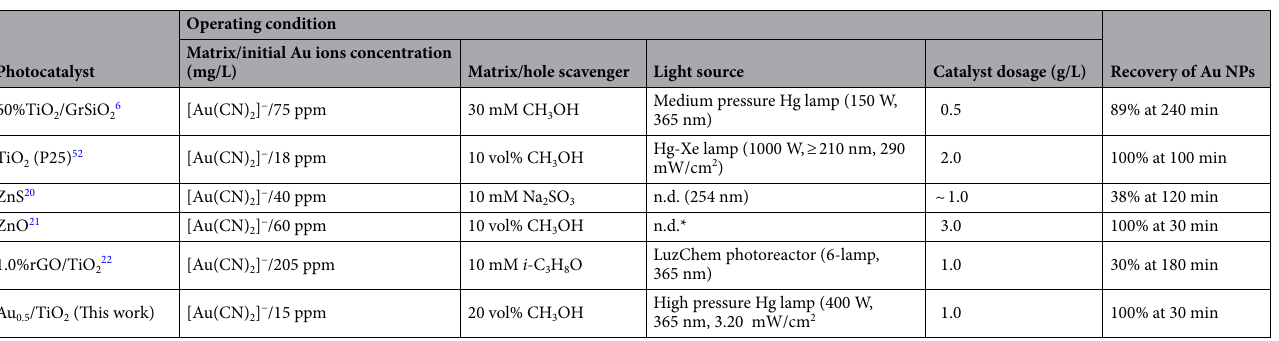
Table 2. Comparative photocatalytic gold recovery from the gold-cyanide plating wastewater via different photocatalysts under UV irradiation. *Not detected.